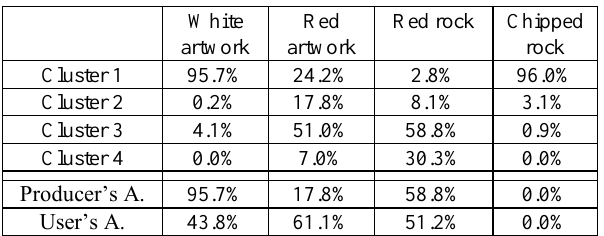
Table 6: Confusion matrix test